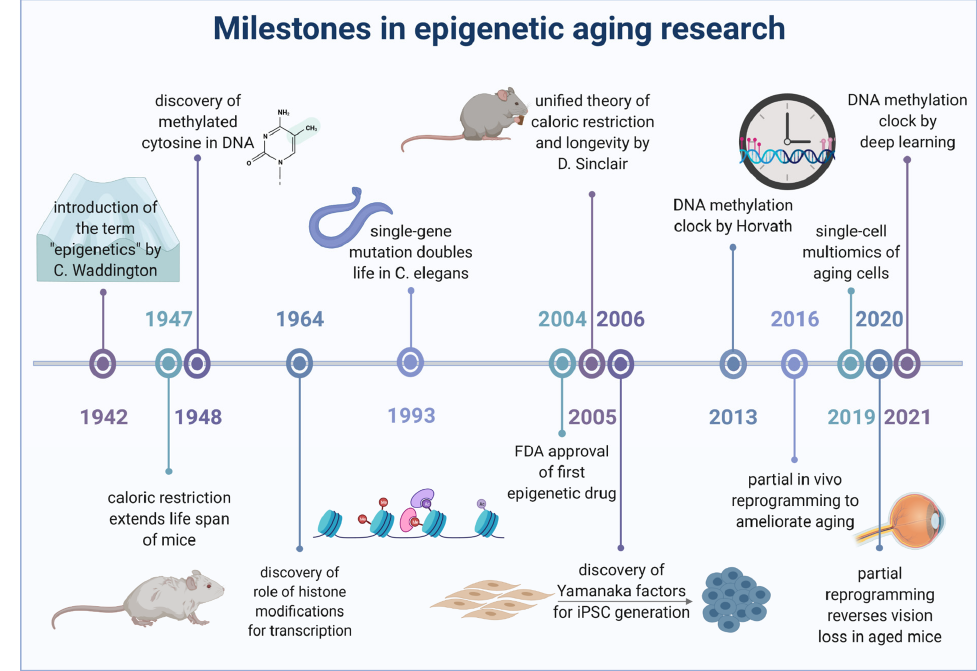
Figure 1. Relevant milestones in research on epigenetic aging and longevity interventions. While research in the 1950s built the foundation for epigenetic studies and in-depth analyses of longevity factors at the beginning of the new century, recent research focuses more and more on methods to directly exploit epigenetic mechanisms to prevent or even reset aging.